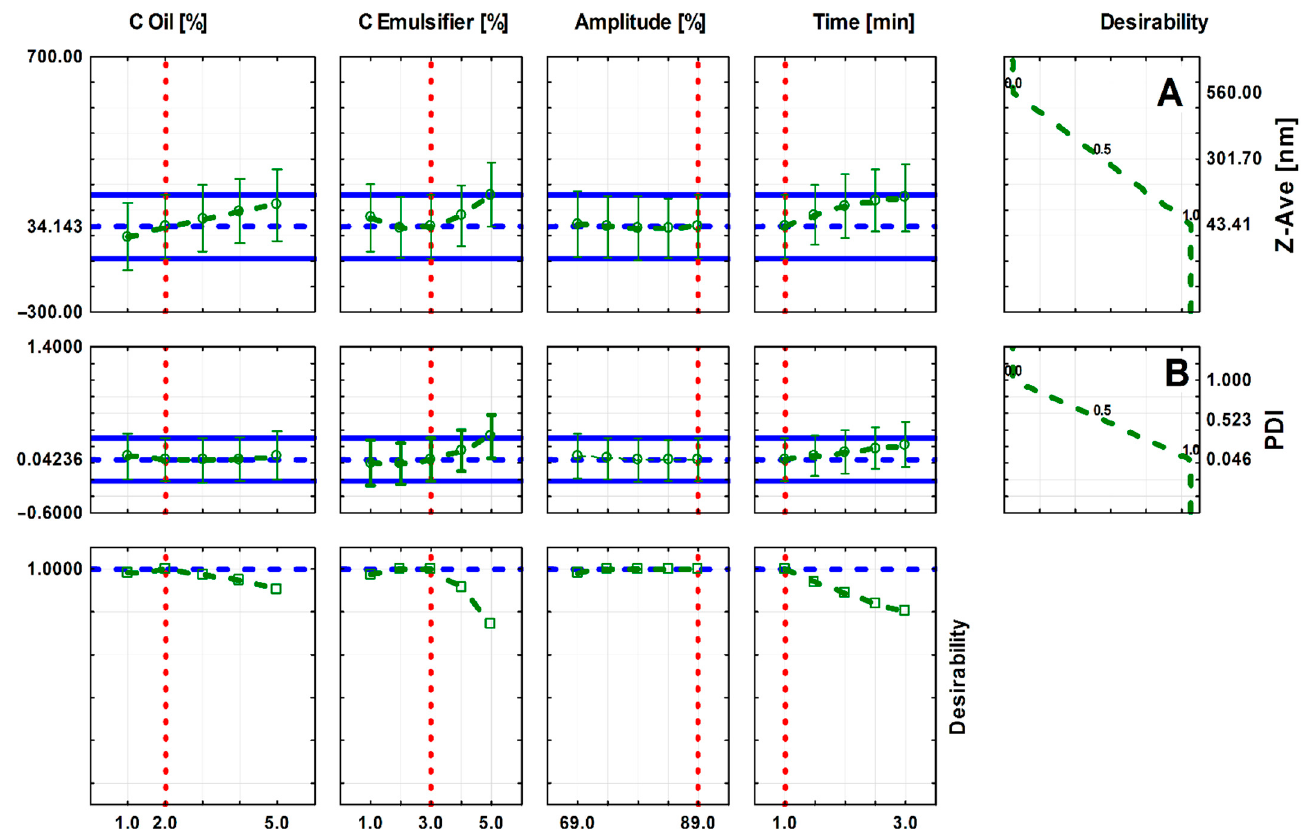
Figure 2. Approximation profiles for the influence of input parameters on ( A ) an average droplet size (nm) of nanoemulsions (nm), ( B ) polydispersity index (PDI).